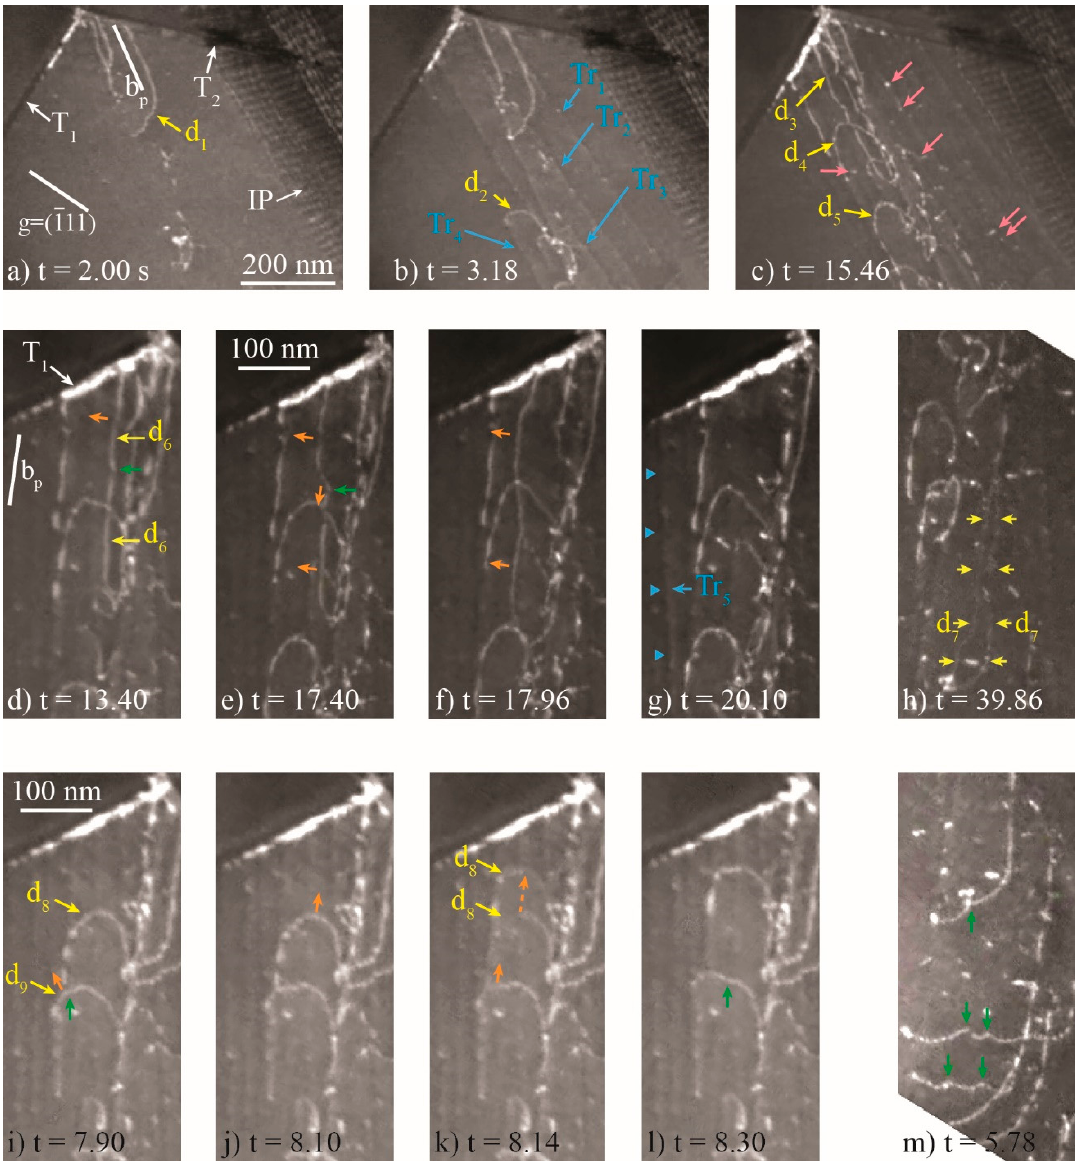
Figure 7. Movements of ordinary dislocations and formation of slip traces in the γ phase of the TNM + alloy as observed by in situ tensile tests at room temperature in a TEM. ( a – c ) global movements of several ordinary dislocations and formation of several traces; ( d – i ) glide of a screw dislocation d 6 ; ( h ) illustration of the rapidity of the movement through the observation of the initial and final positions of a jump on the same frame; ( i – l ) glide of two non-screw dislocations d 8 and d 9 ; and ( m ) pinning points on non-screw segments. g is the direction of the diffraction vector used for the images. b p is the projection of the Burgers vector (b = a/2[110]) in the observation plane. See text for details about other indications reported in this figure and about the description of the movements. The times which are reported are those of the